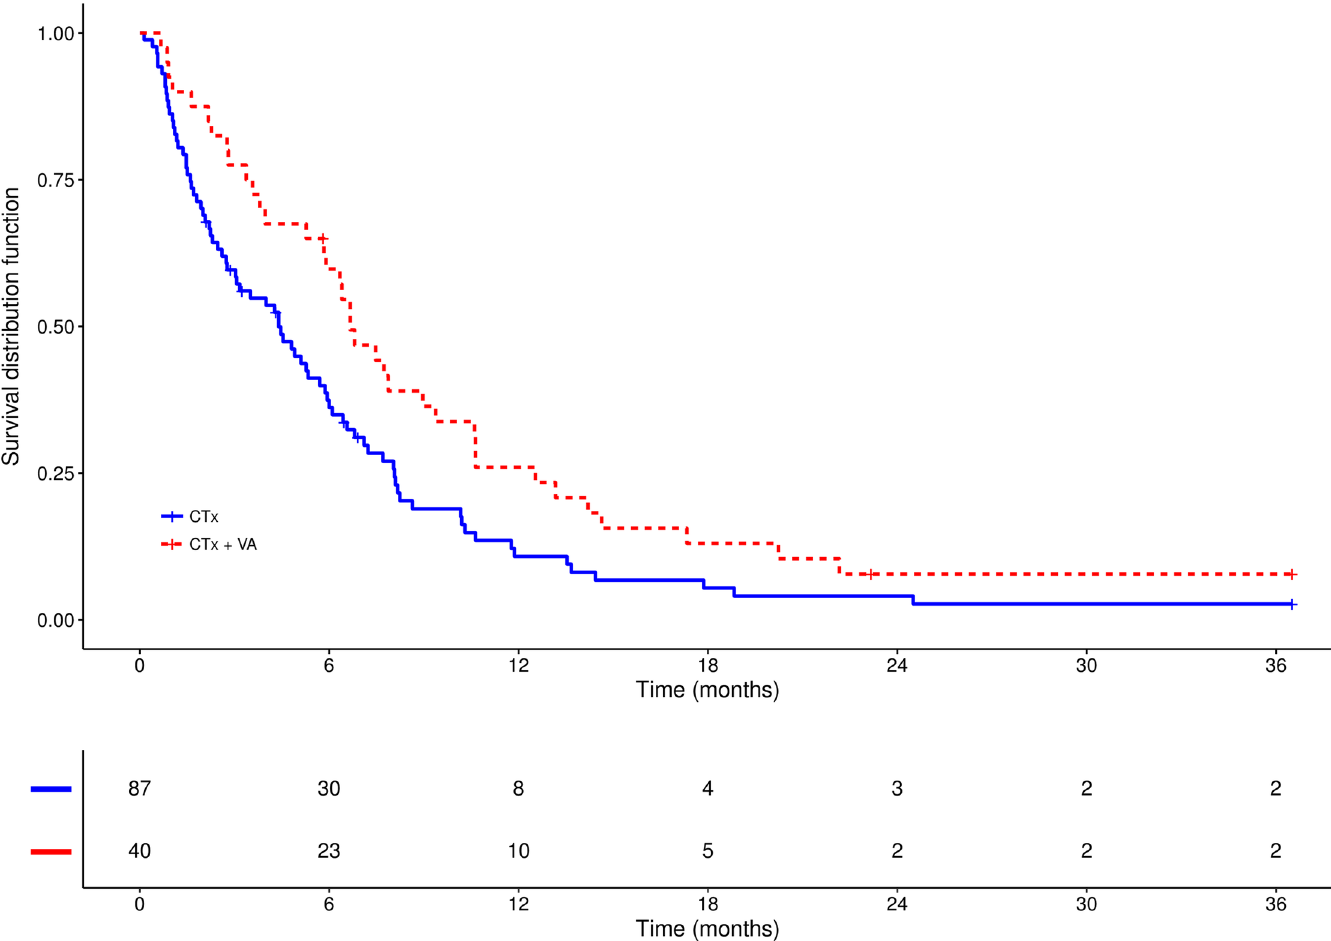
Fig 4. Kaplan-Meier curves of progression-free survival (PFS) for the both treatment cohorts CTx and CTx + VA. Median PFS CTx: 4.4 months (95%CI: 2.7–5.9) vs. median PFS CTx+VA: 6.7 months (95%CI: 4.0–9.0), χ 2 = 3.4, p = 0.06.